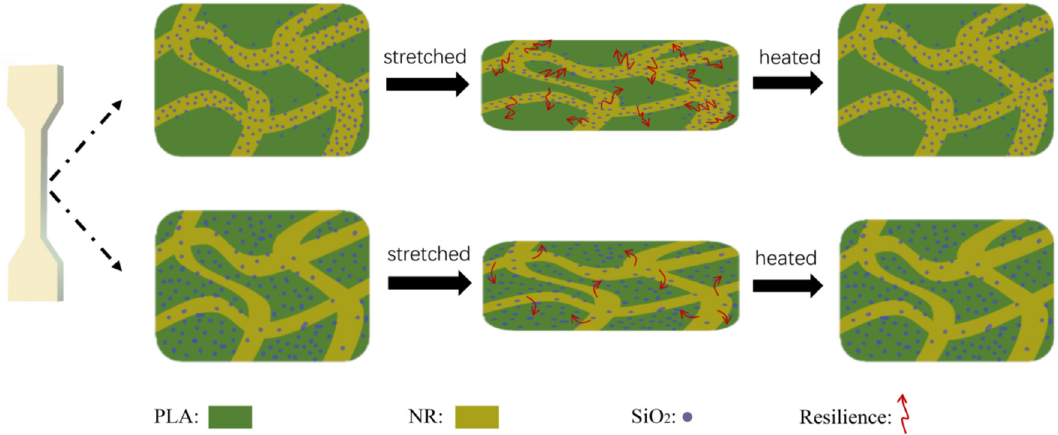
Figure 10. The shape memory behaviour of two types of TPVs. (Reproduced with permission from [82]), Elsevier, 2020).